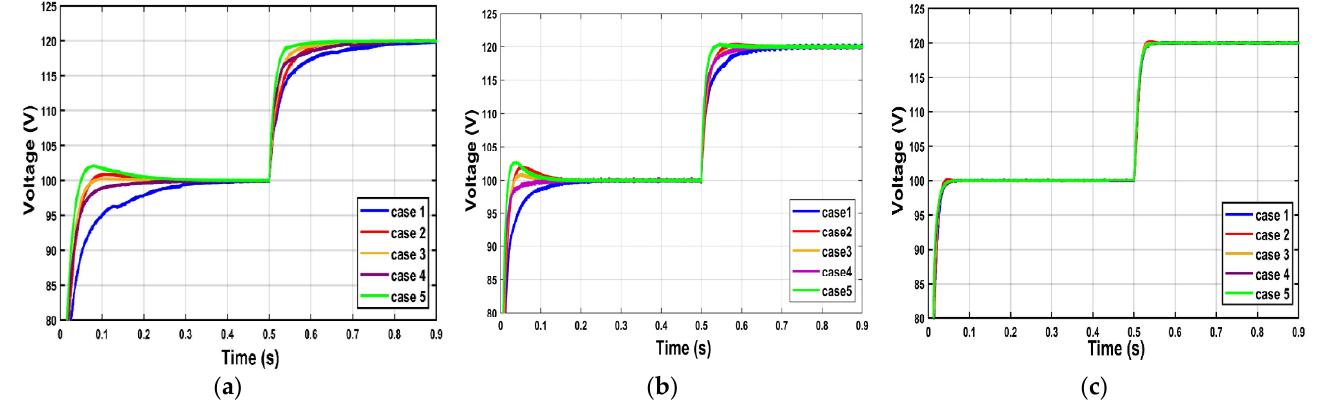
Figure 8. Output voltage responses with different operation points, ( a ) PI control ( b ) SMC ( c ) pro-